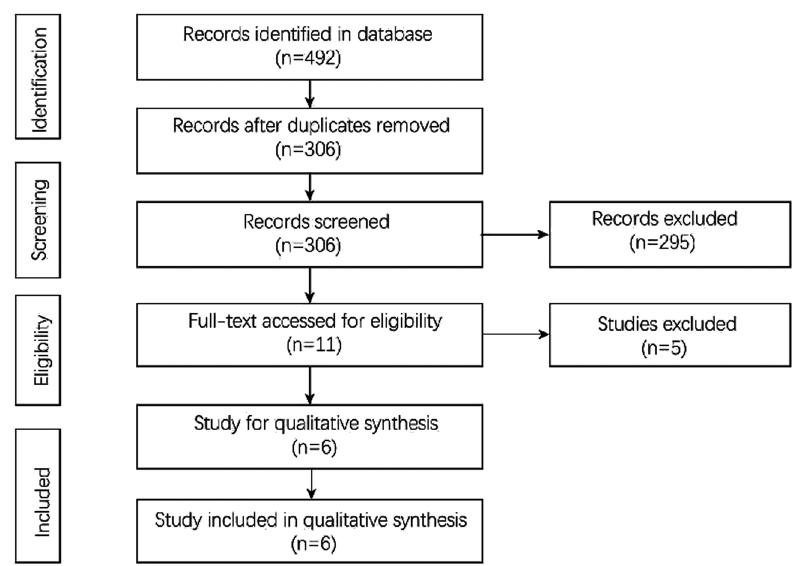
Figure 1: Flowchart of study